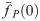
During ineffective community selection, community function correlates weakly with its heritable determinant and strongly with nonheritable determinants.(A) Schematic of community lineages across “previous” and “current” selection cycles. (B-G) Data of Newborns and corresponding Adults (previous cycle) were taken from the 180th cycle of the simulation displayed in black in Fig 3A and 3B. We then allowed each Adult to reproduce Newborns (current cycle), forming 100 lineages (tubes with the same color outline belong to the same lineage). (B–D) Among the 3 determinants of community function, f¯P(0) (fP averaged among M cells in Newborn) is heritable, but BM(0) (total biomass of Newborn) and ϕM(0) (fraction of M biomass in Newborn) are not. For each lineage, the community function determinant at the previous cycle was scatter plotted against the average value at the current cycle. (E–G) During ineffective community selection (Fig 3B), community function P(T) correlates weakly with heritable determinant but strongly with nonheritable determinants. Each dot represents one community. Magenta dots: "successful" Newborns that achieved the highest community function at adulthood and therefore were chosen to reproduce in the top-dog strategy. The Matlab code for B–D can be found in S2 Code, and the data for E–G can be found in S1 Data. Adult, Adult community; M, Manufacturer; Newborn, Newborn community.